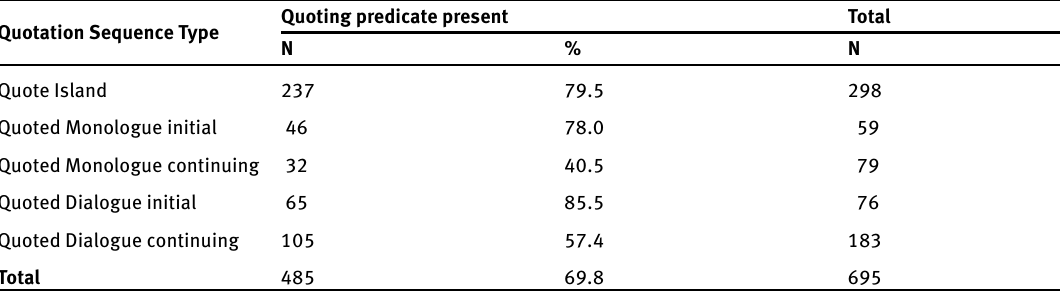
Table 3: Quoting predicates in the three types of quotation